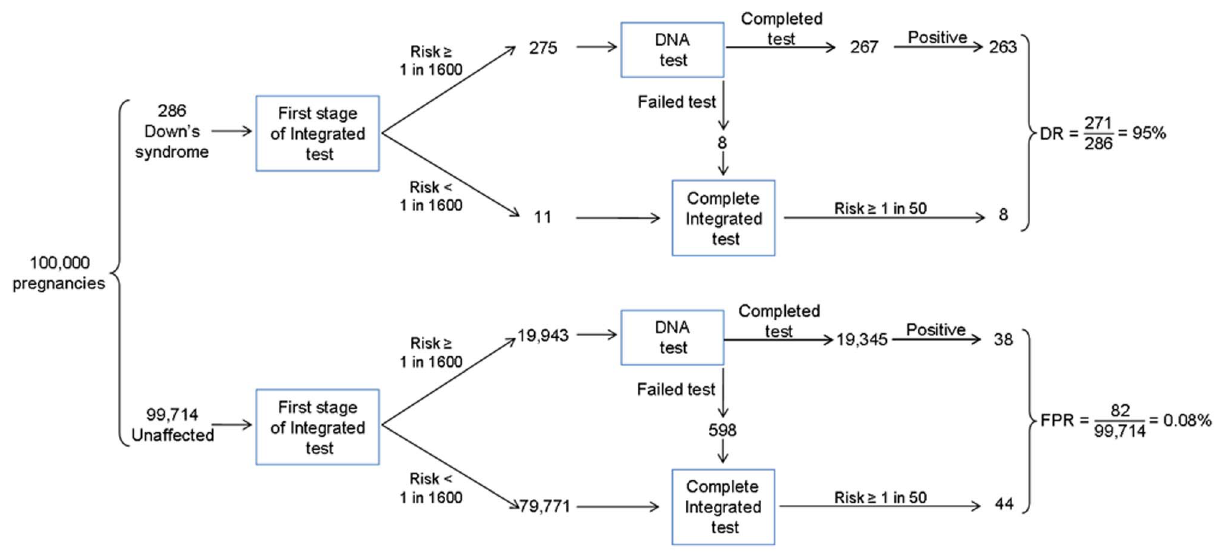
Figure 2. Protocol for reflex DNA testing in conjunction with Integrated test screening in which 20% of women at highest risk using NT, PAPP-A, and free b -hCG (first part of the Integrated test) receive a DNA sequencing test.